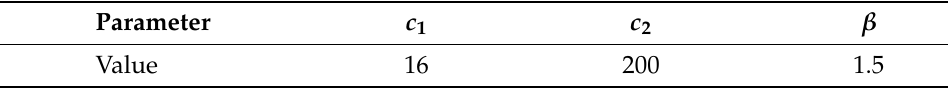
Figure 3. Control principle block-diagram of the proposed DFCTC law. Parameters of REDFTO (11) are listed in Table 1. Parameters of the proposed DFCTC law and the compared FTCA law are listed in Table 2. According to (18) and Table 1, convergence time T 1 of the REDFTO (11) is T 1 = 0.66. Table 1. Parameters of the REDFTO.